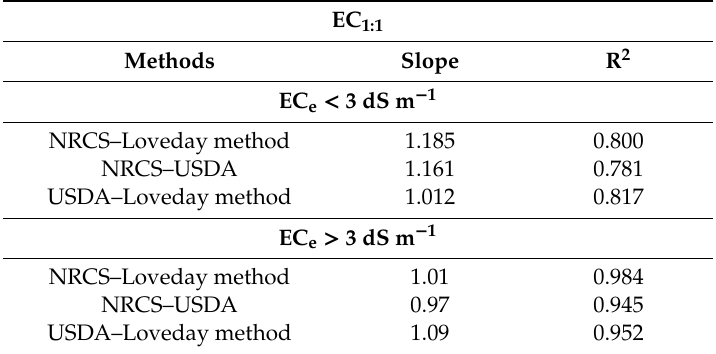
Table 3. Slopes of the linear equations describing the relation between 1:1 soil to water extract